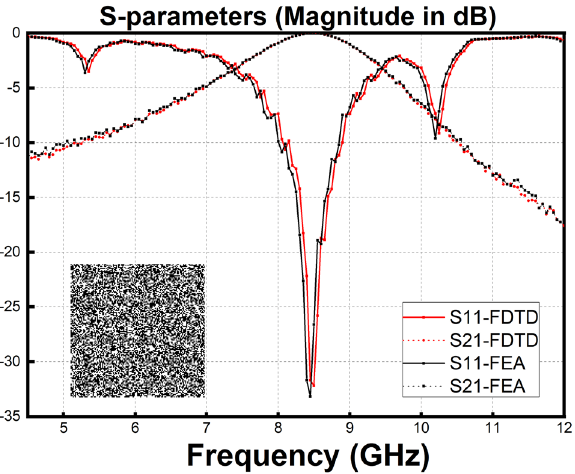
Figure 6. The pattern and S-parameters of the most optimal result. FDTD and FEA method are used to verify the final result. According to the S parameter curve, the best individual of the 30,000th generation of GA process using golden section point reference value has a center frequency near 8.50 GHz, which is stick to the objective value we have